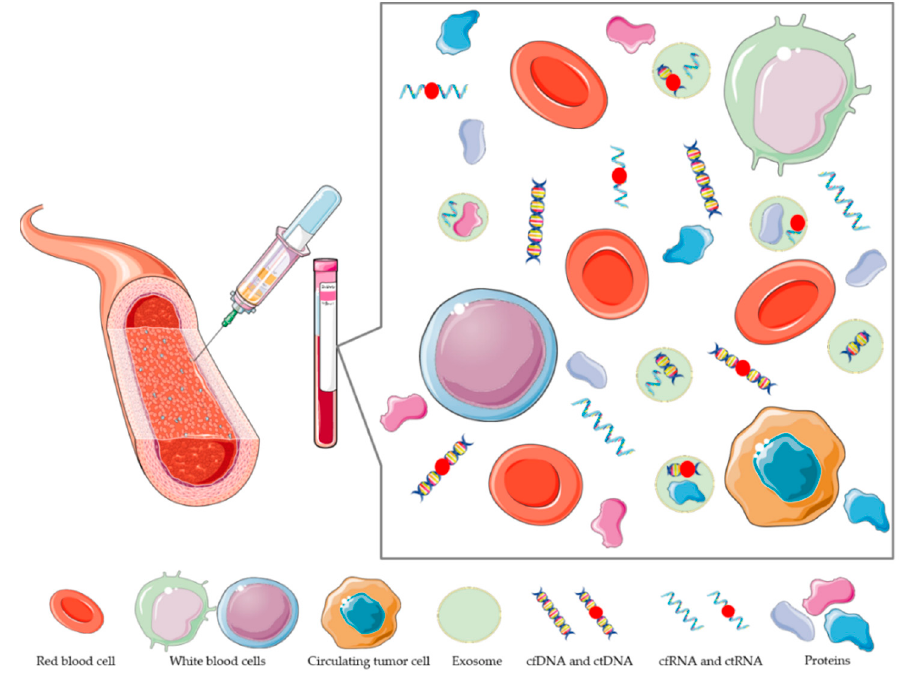
Figure 1. Schematic presentation of blood content. To obtain tumor information circulating tumor cells, circulating tumor DNA (ctDNA) and exosomes are analyzed from blood biopsy. The picture is for graphical illustration only, and does not represent actual sizes, size ratios among particles, or quantity of analytes. TheimagewascreatedusingServierMedicalArt(SMART)(https: // smart.servier.com / ). Servier Medical Art by Servier is licensed under a Creative Commons Attribution 3.0 unsupported